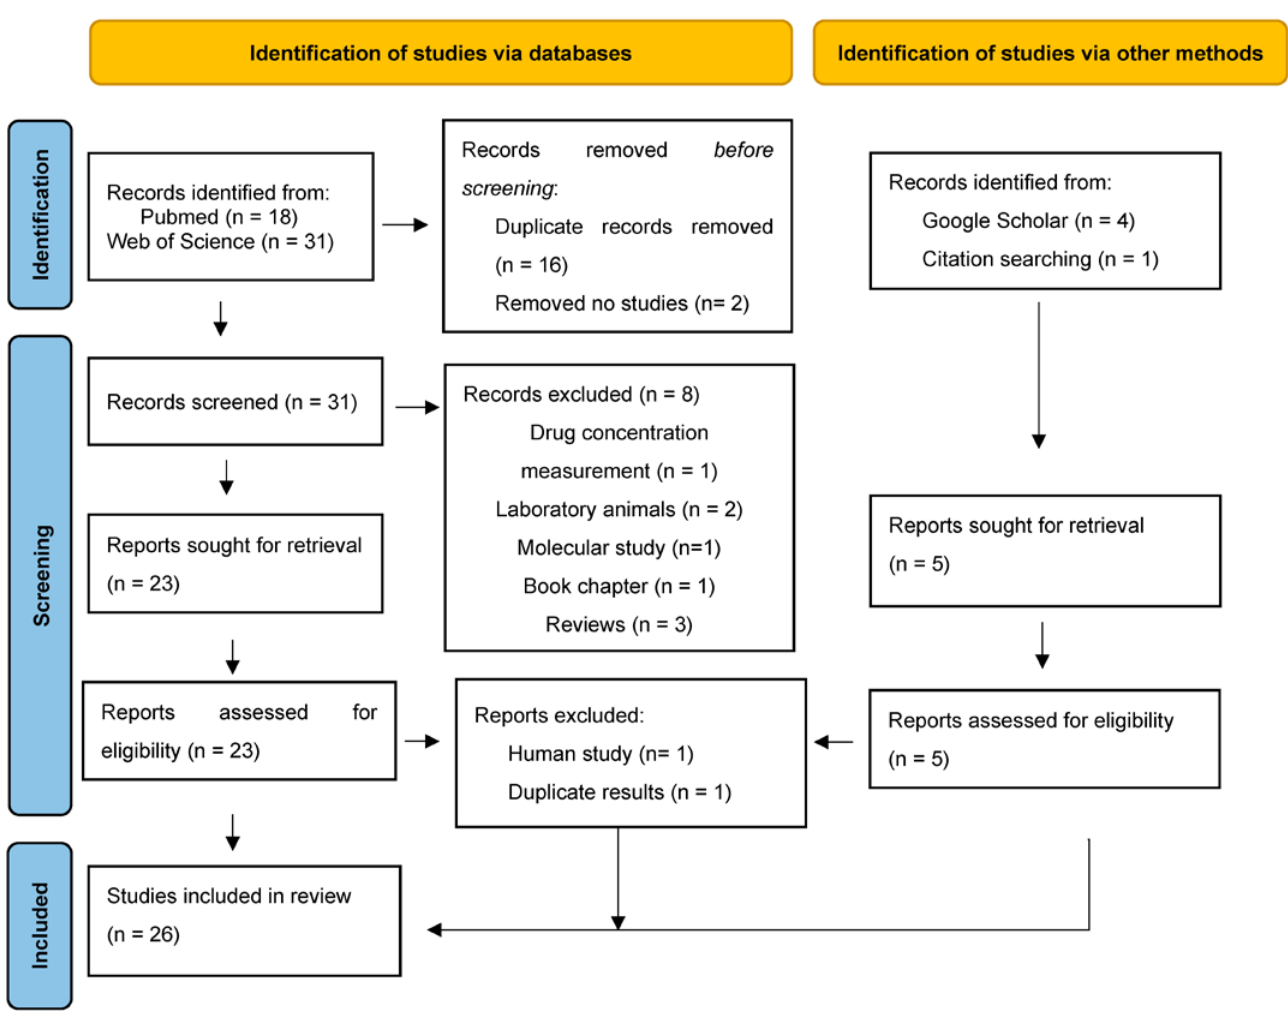
Figure 1. Flowchart of the selection process for scientific records to be analysed in this review.